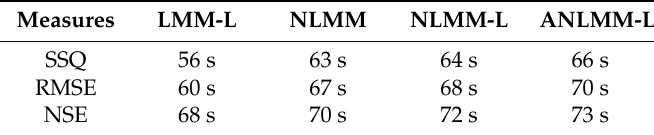
Table 3. Average computational time for the Wilson flood data using VCA.